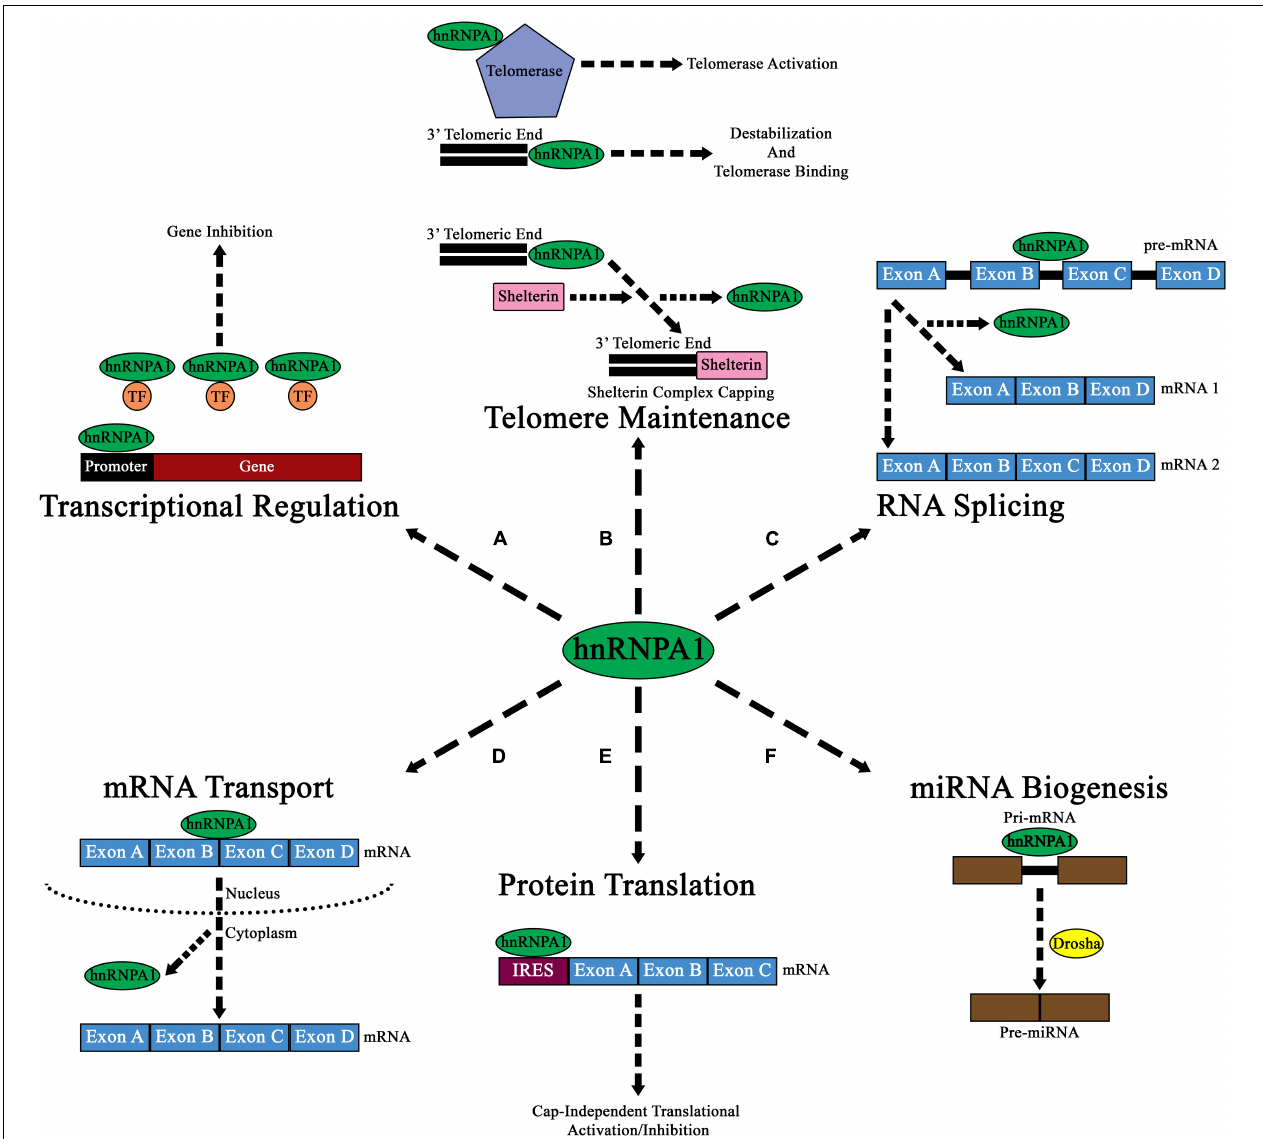
FIGURE 2 | Diagram of the major cellular functions of hnRNP A1. (A) Nuclear hnRNP A1 can regulate transcriptional expression by either promoter regulation, or by binding and sequestering transcription factors (TF; orange circles). (B) hnRNP A1 can also regulate telomeric elongation and capping either via telomerase binding and activation, direct 3’ telomeric end binding, or by aiding in the binding of Shelterin complex proteins. The results of these interactions are to prevent NHEJ and telomere degradation. (C) Pre-mRNA splicing is a major component of hnRNP A1 nuclear function, and its binding can result in the formation of various mRNA isoforms from a single pre-mRNA transcript. (D) mRNA transport from the nucleus to the cytoplasm has been shown to be a major function of hnRNP A1, where hnRNP A1 directs mRNA to ribosomes for cap-dependen translation. (E) In addition to directing mRNA to ribosomes for cap-dependent mRNA translation in the cytoplasm, hnRNP A1 can also bind to IRES elements within mRNA and influence cap-independent translational activation or inhibition. (F) hnRNP A1 has been shown to influence the nuclear formation of pre-miRNAs from pri-miRNAs. While the exact mechanism of how hnRNPA1 affects this pathway is unknown, it is theorized that hnRNP A1 may influence Drosha (yellow circle) binding to